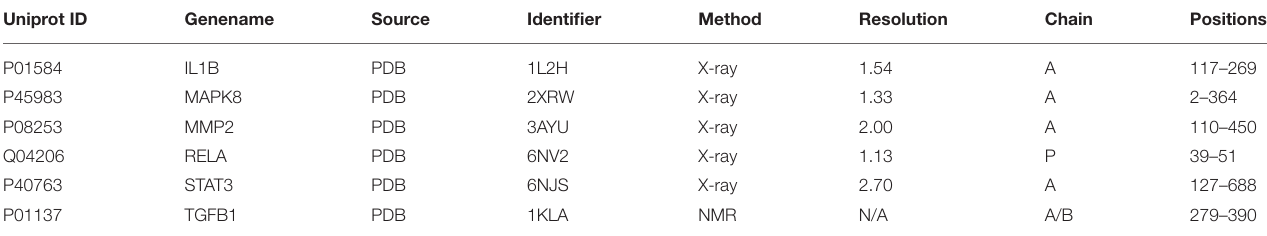
TABLE 4 | The information of six core targets in